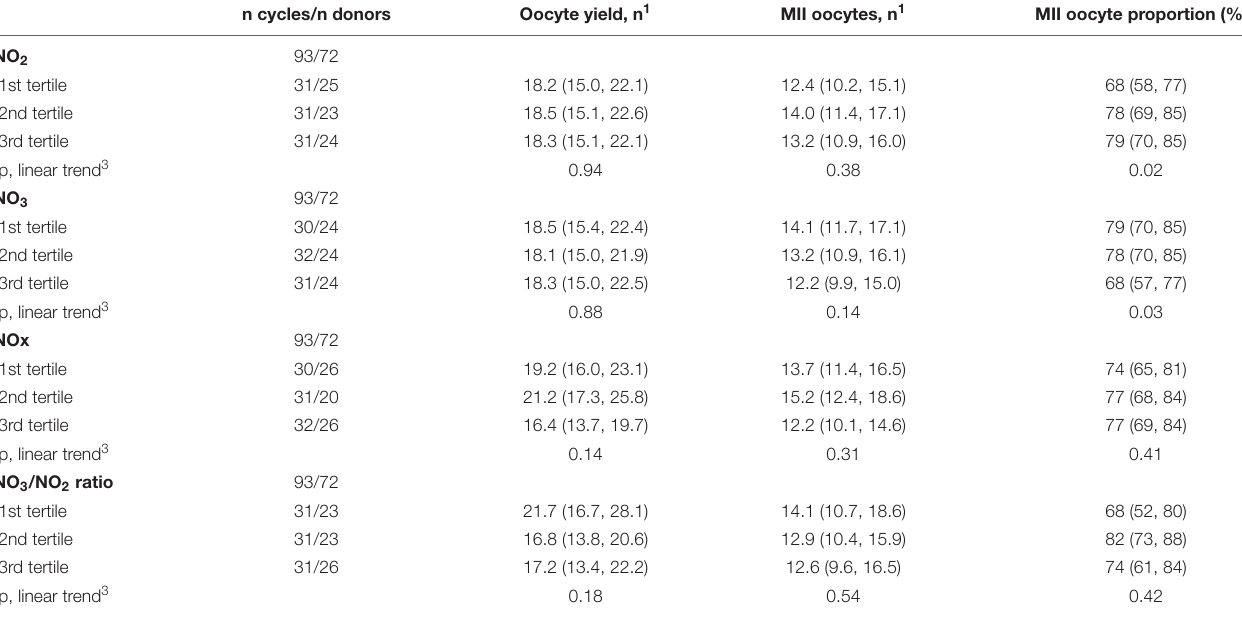
TABLE 4 | Association between nitric-oxide-related parameters and the adjusted oocyte yield, number, and proportion of MII oocytes in of healthy women undergoing ovarian stimulation as part of their participation in an oocyte donation program. n cycles/n donors